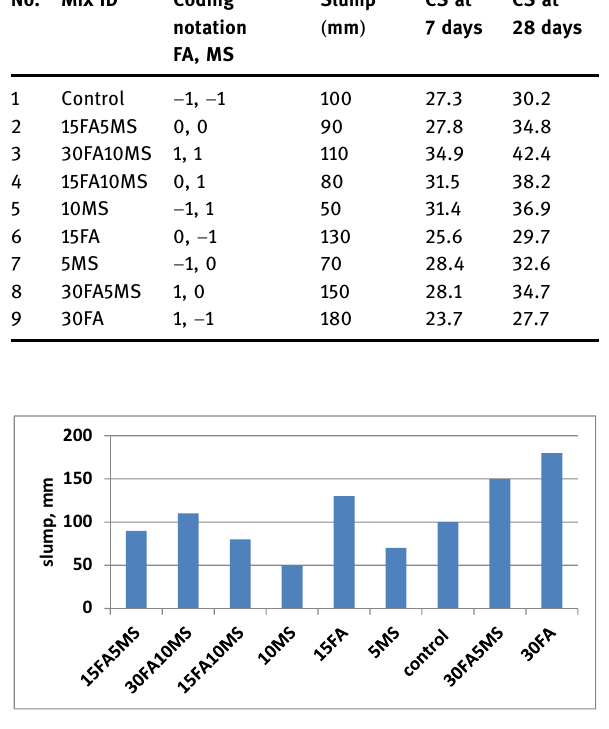
Figure 1: Slump results for all mixtures.